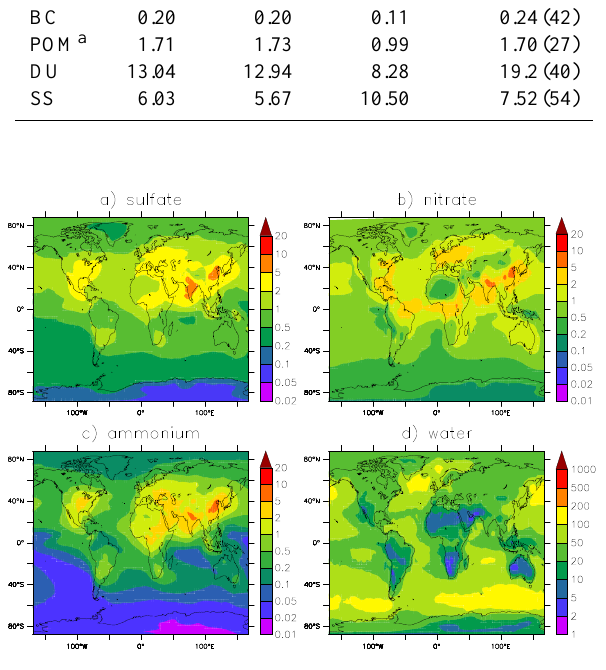
Fig. 7. Annual mean column tropospheric burden of the total con- centration of (a) sulfate, (b) nitrate, (c) ammonium and (d) water. All units are in mgm − 2